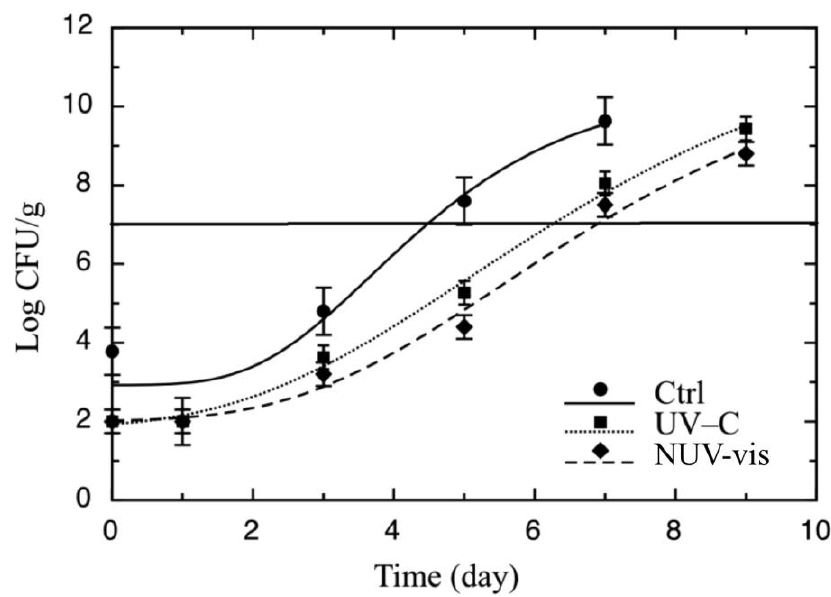
Figure 2. Evolution of Pseudomonas spp. during the shelf life test in ricotta cheese inoculated with P. fluorescens (DSM 50090) (10 3 CFU/mL), treated with UV-C and NUV–vis light, at one light dose per technology, with respective control samples (Ctrl, inoculated, and not treated). A total of 36 samples were treated once, on the same day, which corresponded to time zero of the storage period, and then analyzed for 9 days. The continuous line represents the best fitting of Equation (1) to the experimental counts of Pseudomonas spp. The horizontal line represents the threshold for microbiological acceptability set to 7 log CFU/g.